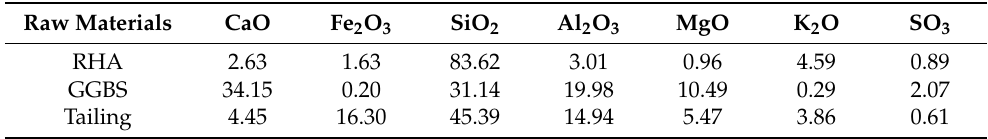
Table 1. Chemical composition of raw materials